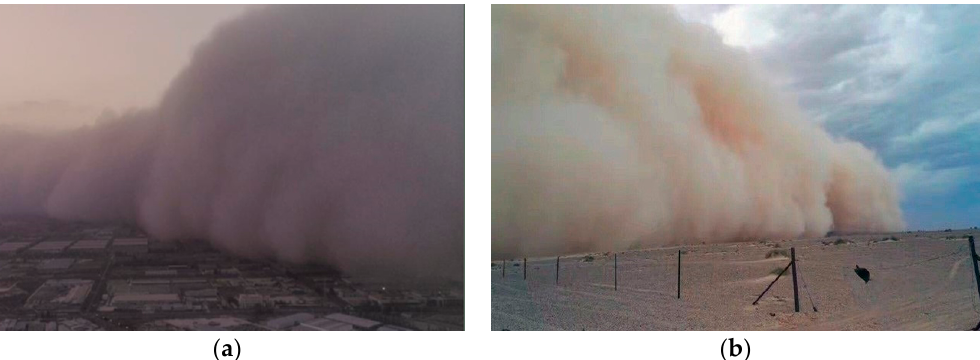
Figure 1. The fronts of two local sandstorms occurred ( a ) on 2019-04-06 in Alar City, Xinjiang Province, China (http://news.2500sz.com/doc/2019/04/08/424594_4.shtml, accessed on 12 December 2020 ); ( b ) on 2017-08-02 in E-Ji-Na County, Inner Mongolia Autonomous Region, China (https://baijiahao.baidu.com/s?id=1574686840525110&wfr=spi-